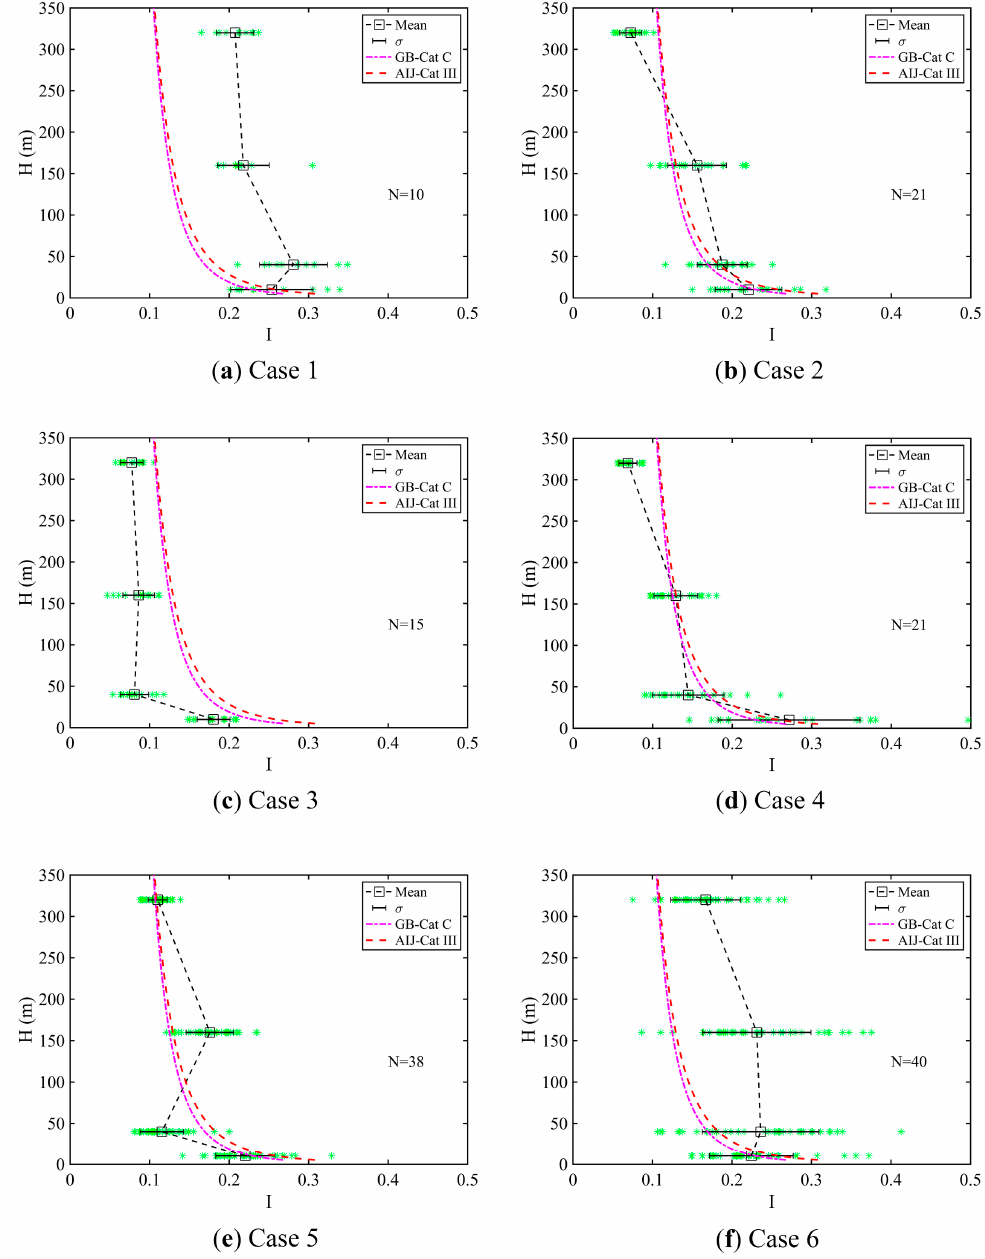
Figure 6. Turbulence intensity profiles of each individual event, total = 6. N refers to the number of samples in each panel.